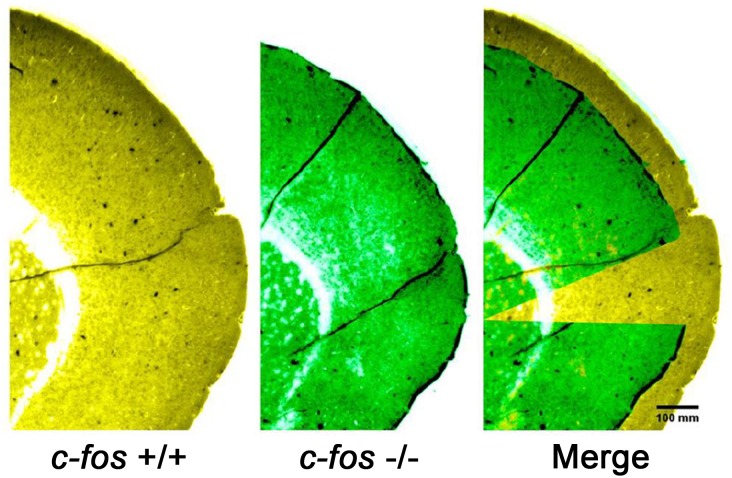
Representative images of brain cortical slices from fos (+/+) mice (left, pseudo colored yellow), fos (–/–) mice (middle, pseudo colored green) and the merged image (right). Note that in the merged image, part of the fos (–/–) image was cropped to better show the superposition of both images. Adapted from Velazquez et al., 2015b (this is an open-access article distributed under the terms of the Creative Commons Attribution License, which permits unrestricted use, distribution, and reproduction in any medium, provided the original author and source are credited).